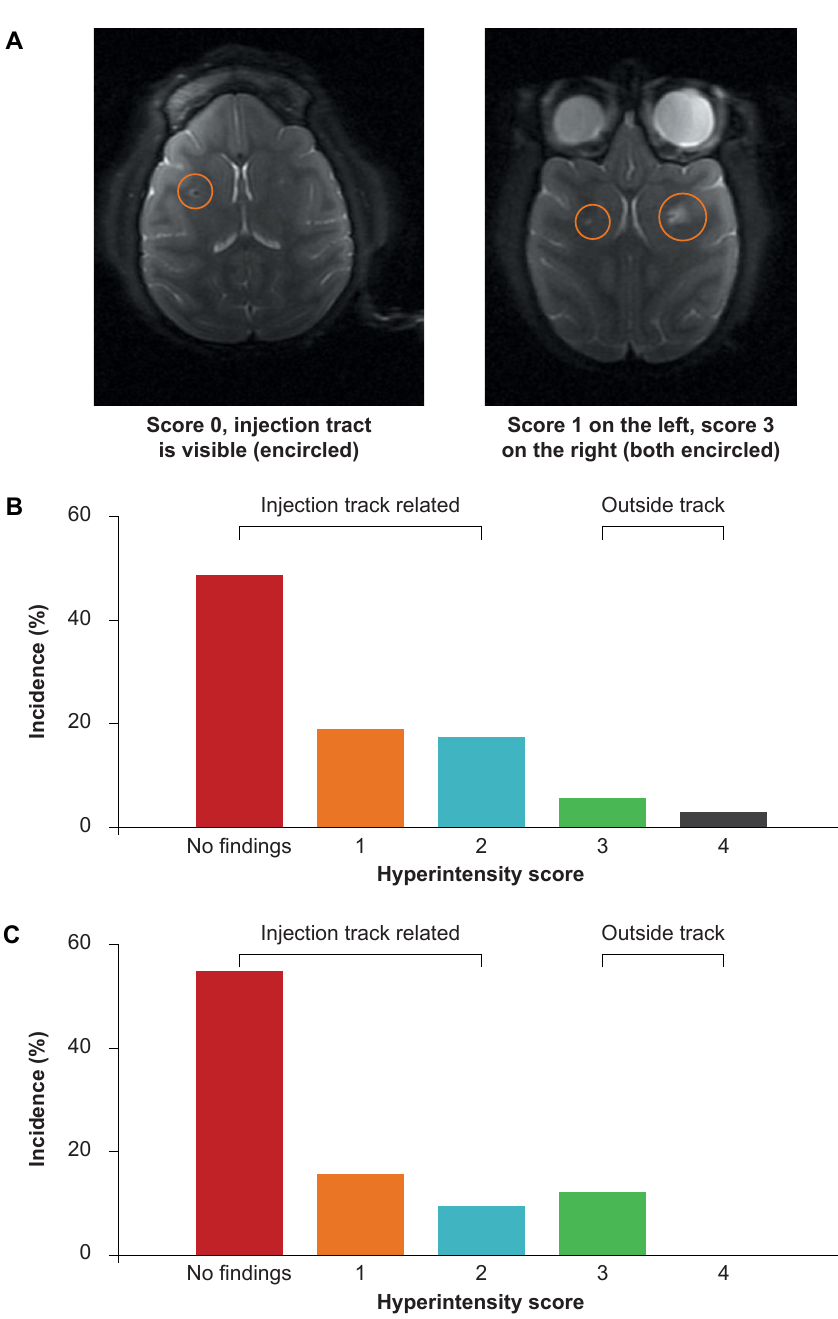
Figure 2. T2 hyperintensities. Seen on MRI, these are an indication of altered fluid content (e.g., blood, edema, inflammation) compared to the surrounding area. Brain MRI from NHP taken 3 and 6 months after dosing indicated that for most injections no hyperintensity was observed and for the injection tracts where hyperintensity was observed in the MR image, a tendency to recovery over time was seen in NHP. ( A ) Examples of hyperintensities seen on MR images. Score 0: track visible, no T2-hyperintensities. Score 1 and 2: T2-hyperintensities directly related to the injection track. Score 1: very small hyperintense dot near the end of the track or incomplete T2-hyperintense circle around the track. Score 2: a small hyperintense dot near the end of the track or complete T2-hyperintense circle around the track. Score 3 and 4: T2-hyperintensities extending outside the area of the injection track. Score 3: within injected area. Score 4 = extending outside the injected area as compared with the dosing MRI. ( B ) Hyperintensity scores 3-months after dosing. ( C ) Hyperintensity scores 6-months after dosing, (incidence in %